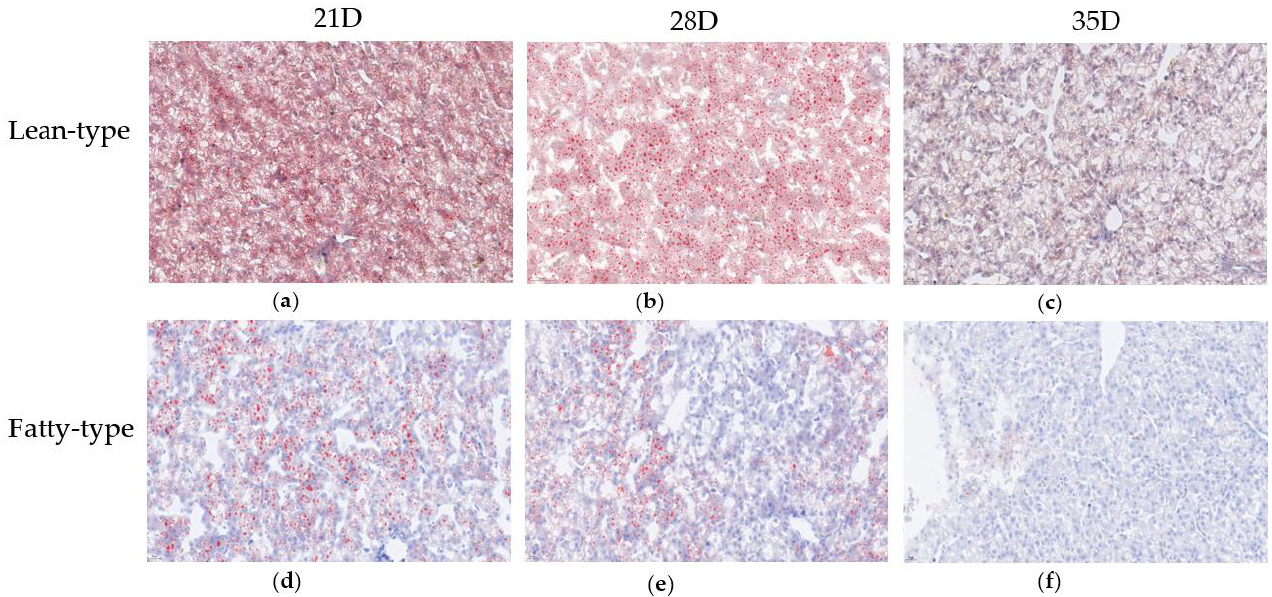
Figure 2. Oil red O staining of liver sections showing the effects of different strains on the hepatic lipid accumulation in the liver of meat duck. Lean-type Pekin ducks after 21 Days of growth ( a ); Fatty-type Pekin ducks after 21 Days of growth ( b ); Lean-type Pekin ducks after 28 Days of growth ( c ); Fatty-type Pekin ducks after 28 Days of growth ( d ); Lean-type Pekin ducks after 35 Days of growth ( e ); Fatty-type Pekin ducks after 35 Days of growth ( f ). The red spots in the pictures are stained lipid droplets. Scale bar: 20 μm.